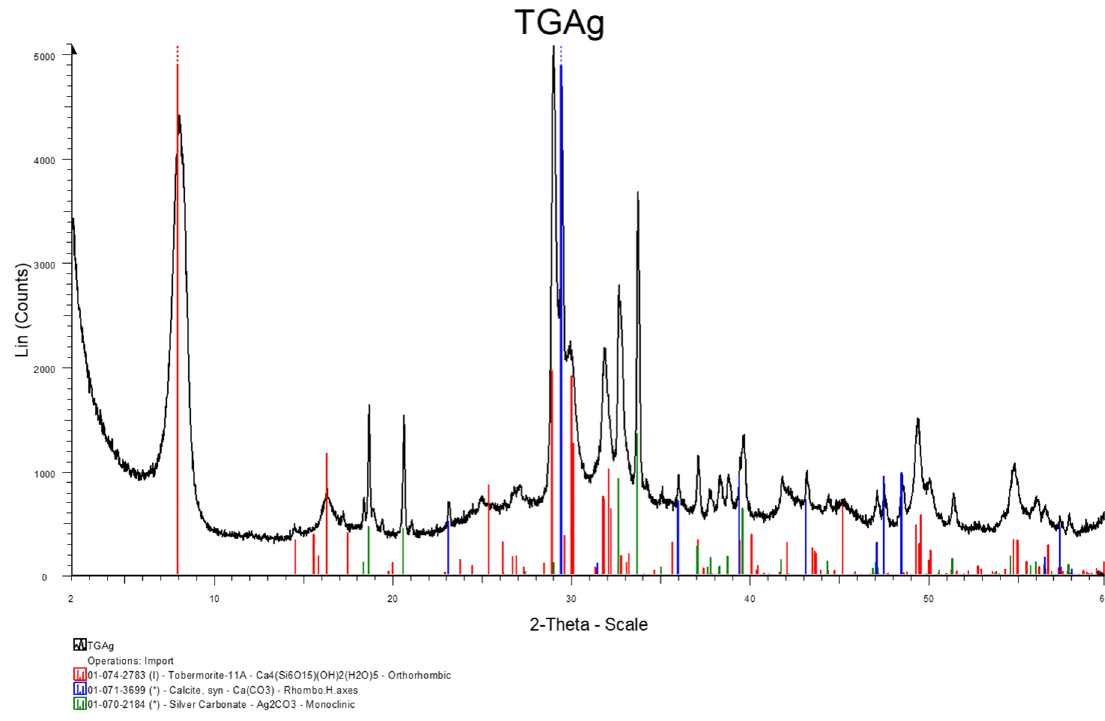
Figure A1. XRD pattern of TG4-Ag showing the identification of reflections from 11 Å tobermorite (PDF 01-074-2783, red lines), calcite (PDF 01-071-3699, blue lines) and silver carbonate (PDF 01-070- 2184, green